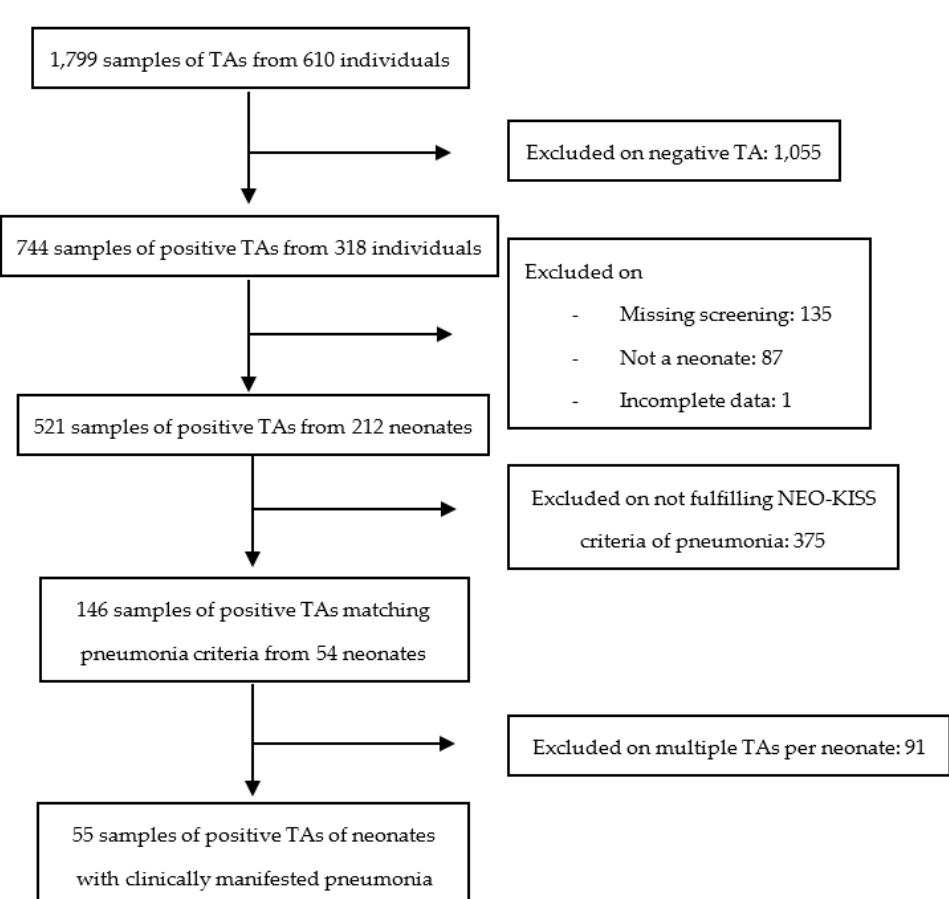
Figure 2. Flowchart and study selection of pneumonia patients study arm. Legend: TA = tracheal aspirate.